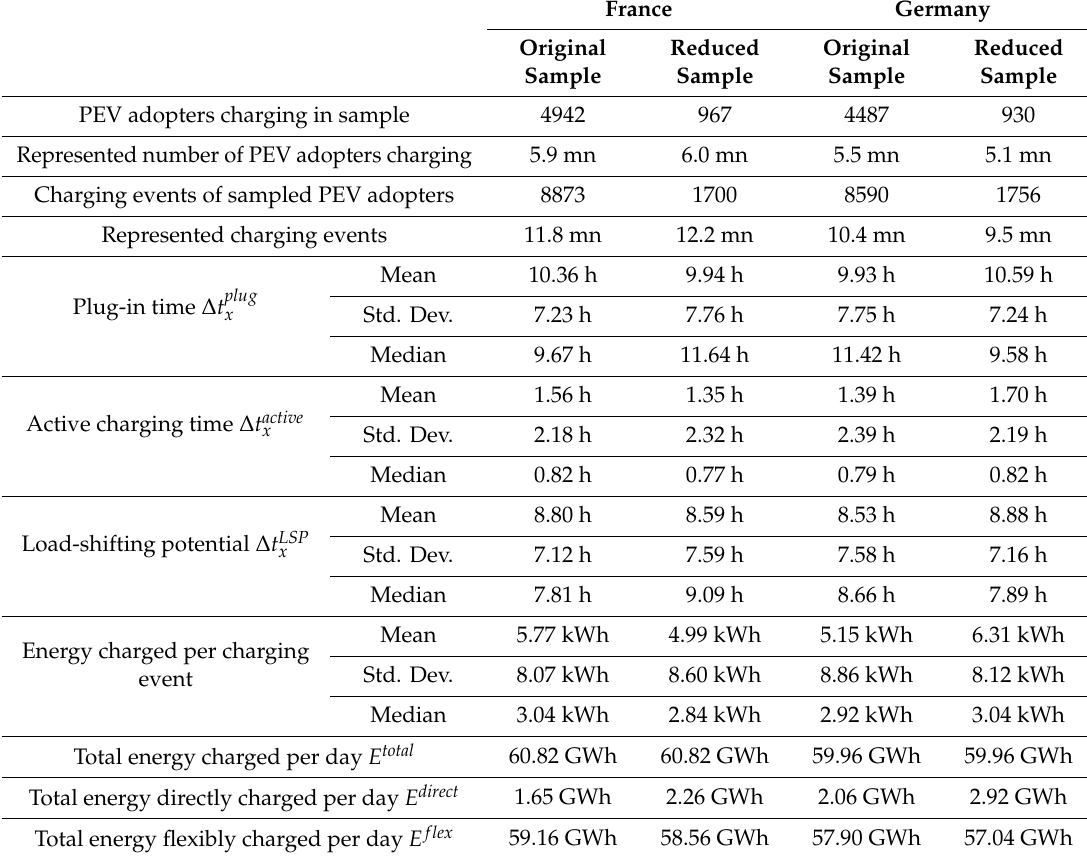
Table 3. Charging behavior with two methods over di ff erent